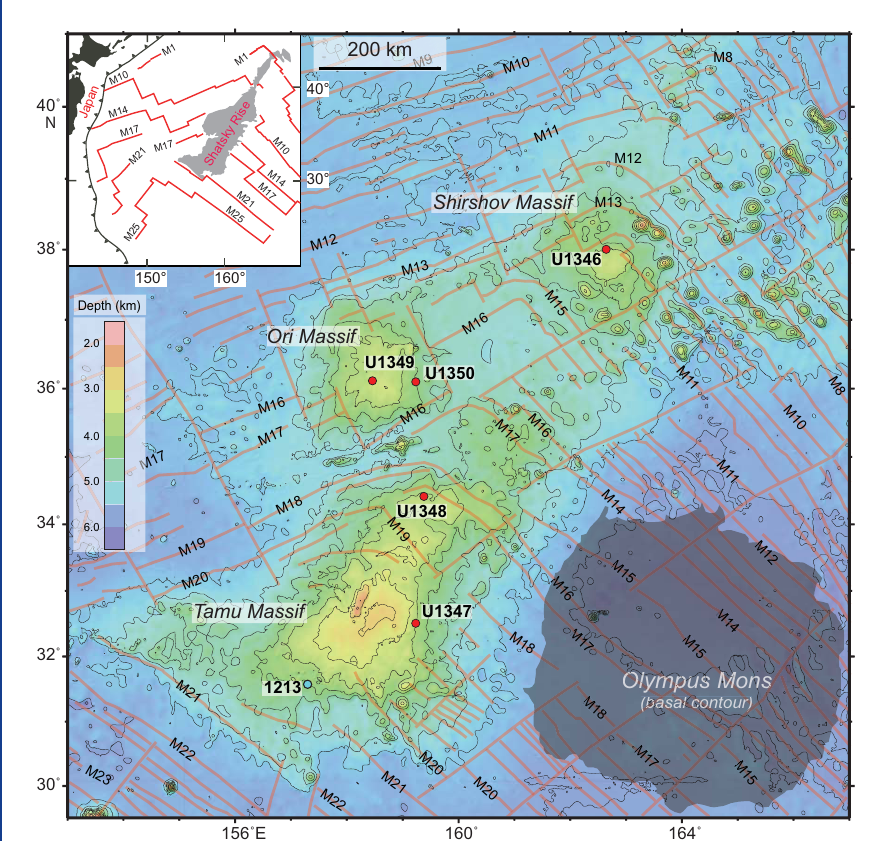
Figure 1. Shatsky Rise, surrounding magnetic lineations and fracture zones (heavy red lines; Nakanishi et al., 1999), Expedition 324 drill sites (red dots) and ODP Site 1213 (blue dot). Dark area at lower right shows the basal contour of Olympus Mons (Mars) at the same scale. Inset shows the location of Shatsky Rise relative to